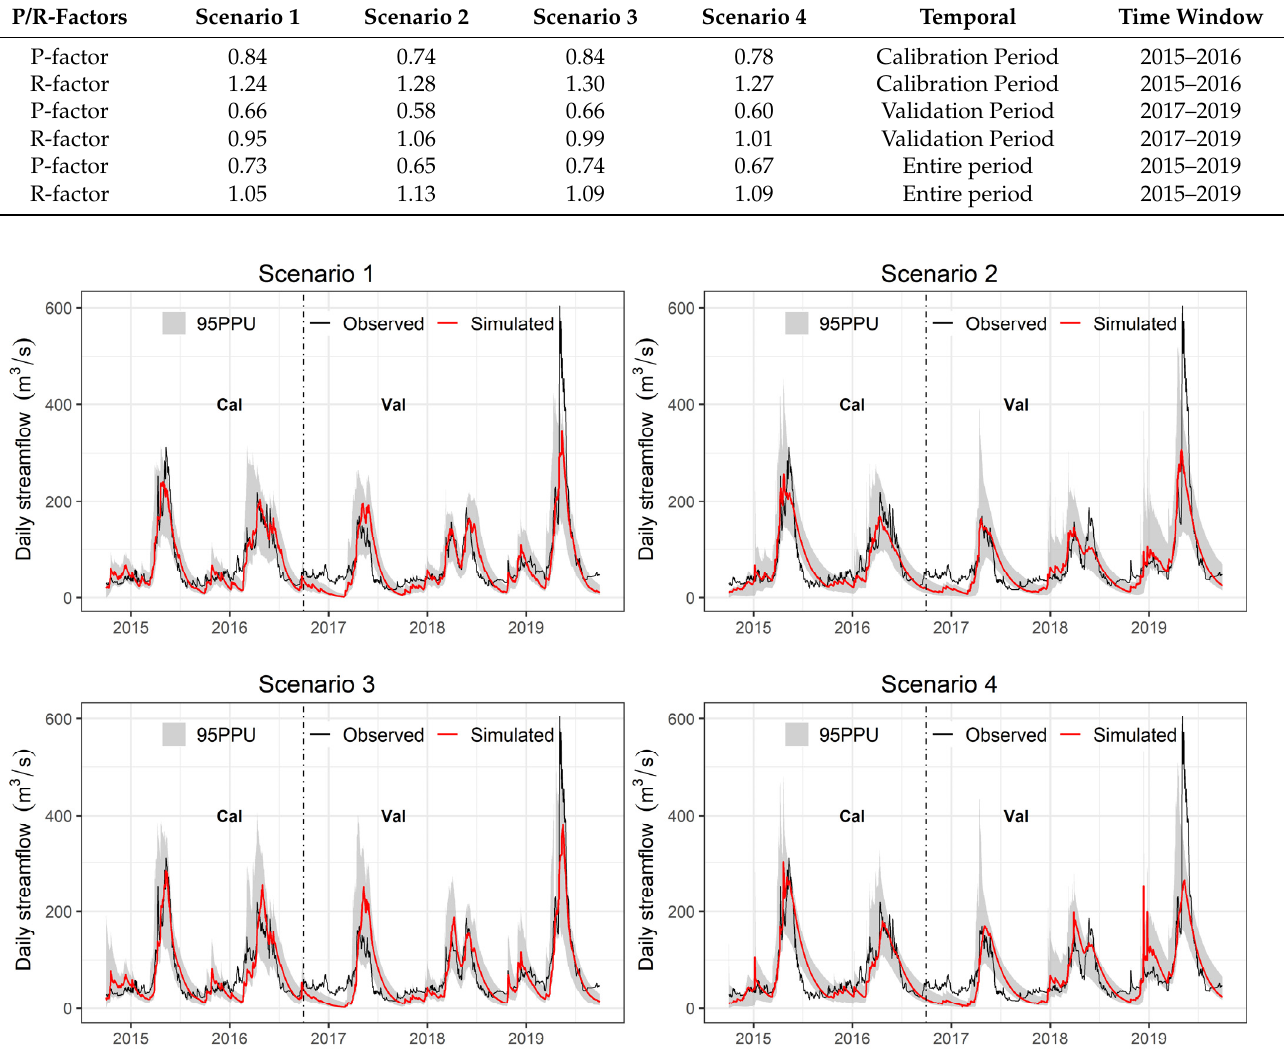
Table 2. The 95PPU of streamflow simulation for four scenarios expressed in the form P factor and R factor.